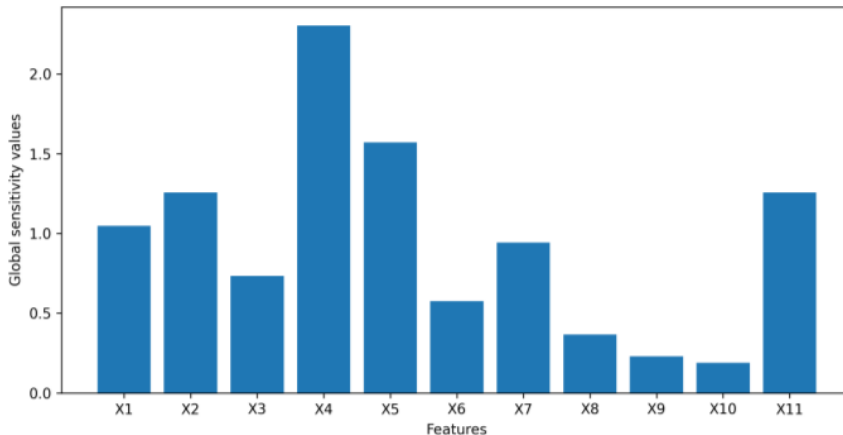
Figure 13. Local feature importance values for dataset 3.